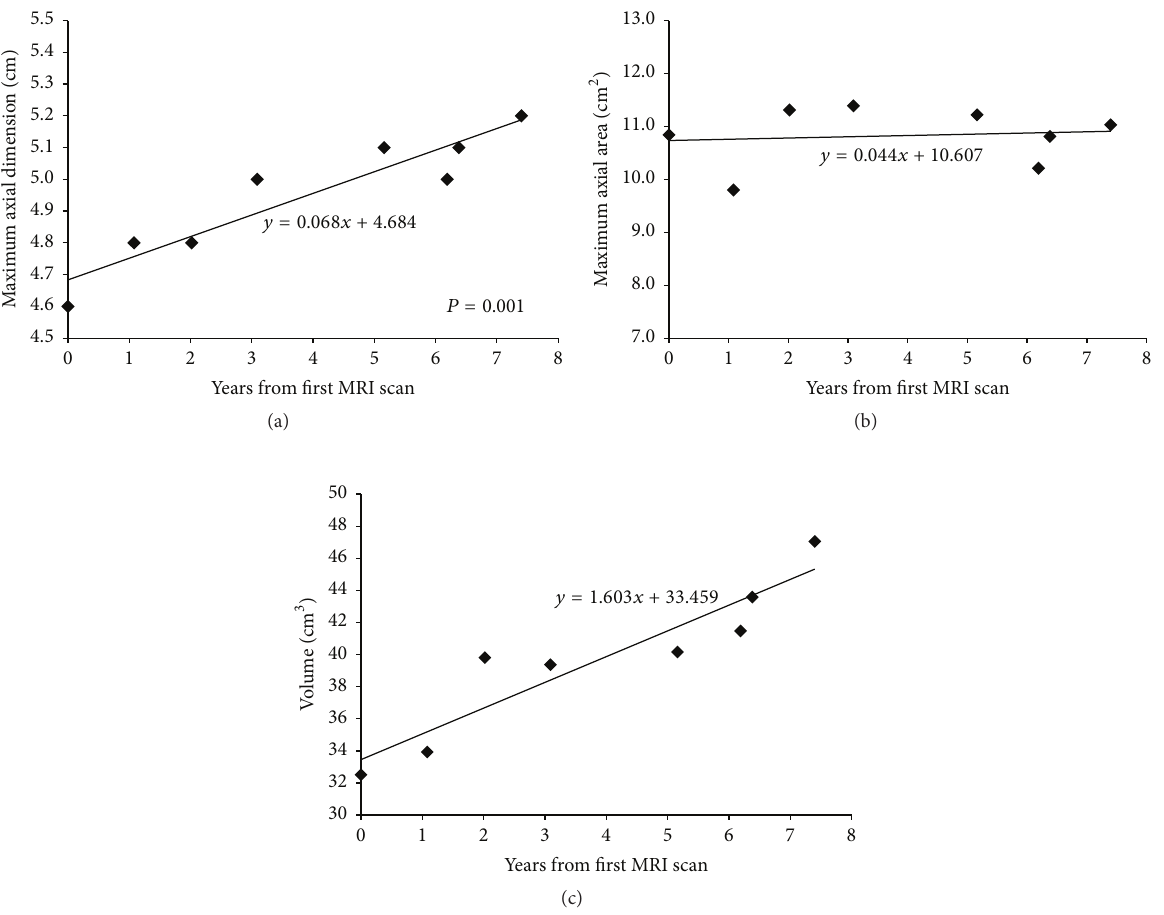
Figure 2: Growth rates of the untreated left glomus vagale on serial MRI scans as estimated by linear regression model. (a) Maximum axial dimension demonstrates a growth rate of 0.68 mm/year in a linear trend. (b) Maximum axial area illustrates a stable trend, with a growth rate of 0.04 cm 2 /year. (c) Volume demonstrates a growth rate of 1.6cm 3 /year in a linear